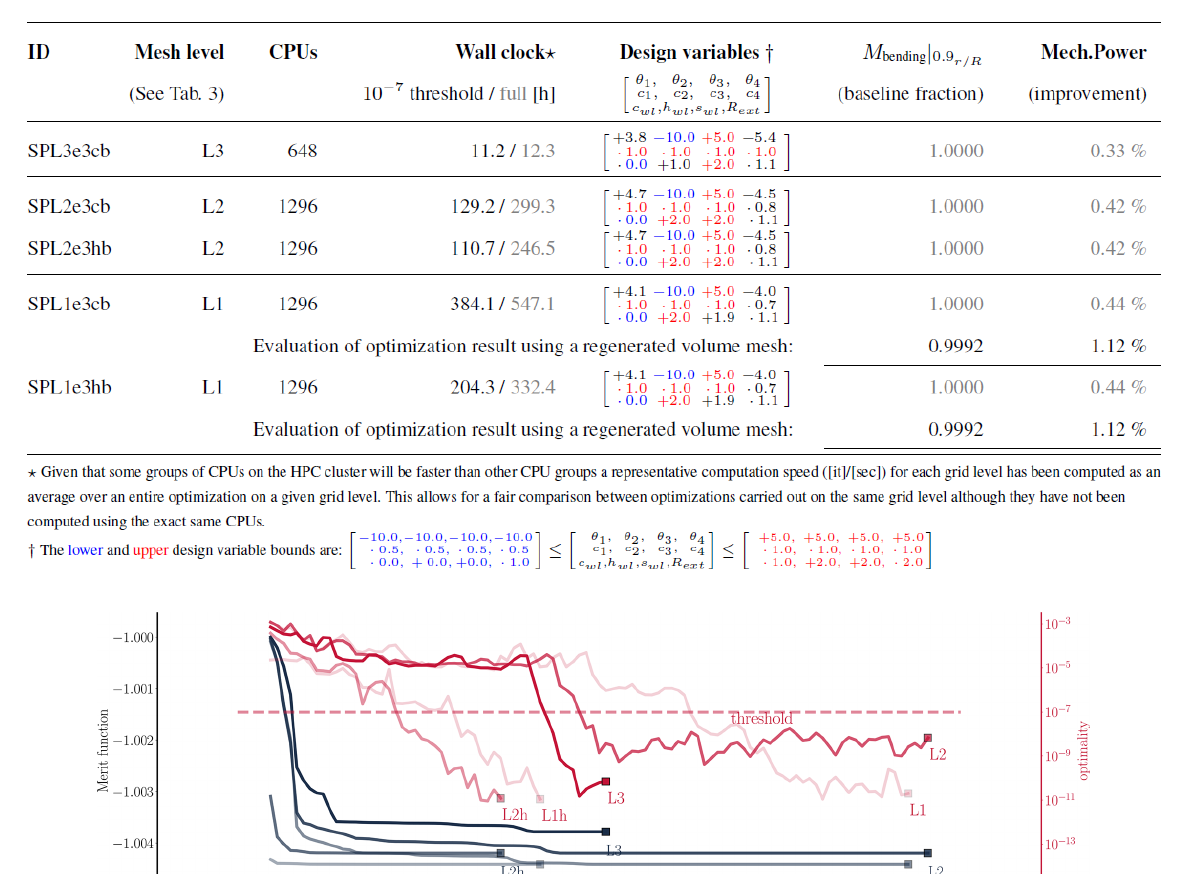
Table 6. Overview of optimized shapes obtained from CFD-based shape optimizations of wind turbine blade tips. Operational conditions are found in Table 2. The naming convention explanation using “SPL1e3hb” as an example is as follows. SP: a single-point optimization; L1: on mesh level L1; e3: using a finite difference step size of 10 − 3 ; h: (hot-)started from the optimized shape on L2; and b: with limited design variable bounds that work on all grid levels. All optimizations were carried out using either 648 (L3) or 1296 (L2, L1) CPUs split into 12 groups – one group of either 54 (L3) or 108 (L2, L1) CPUs for each design variable.